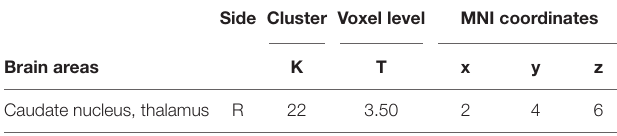
Side Cluster Voxel level MNI coordinates Brain